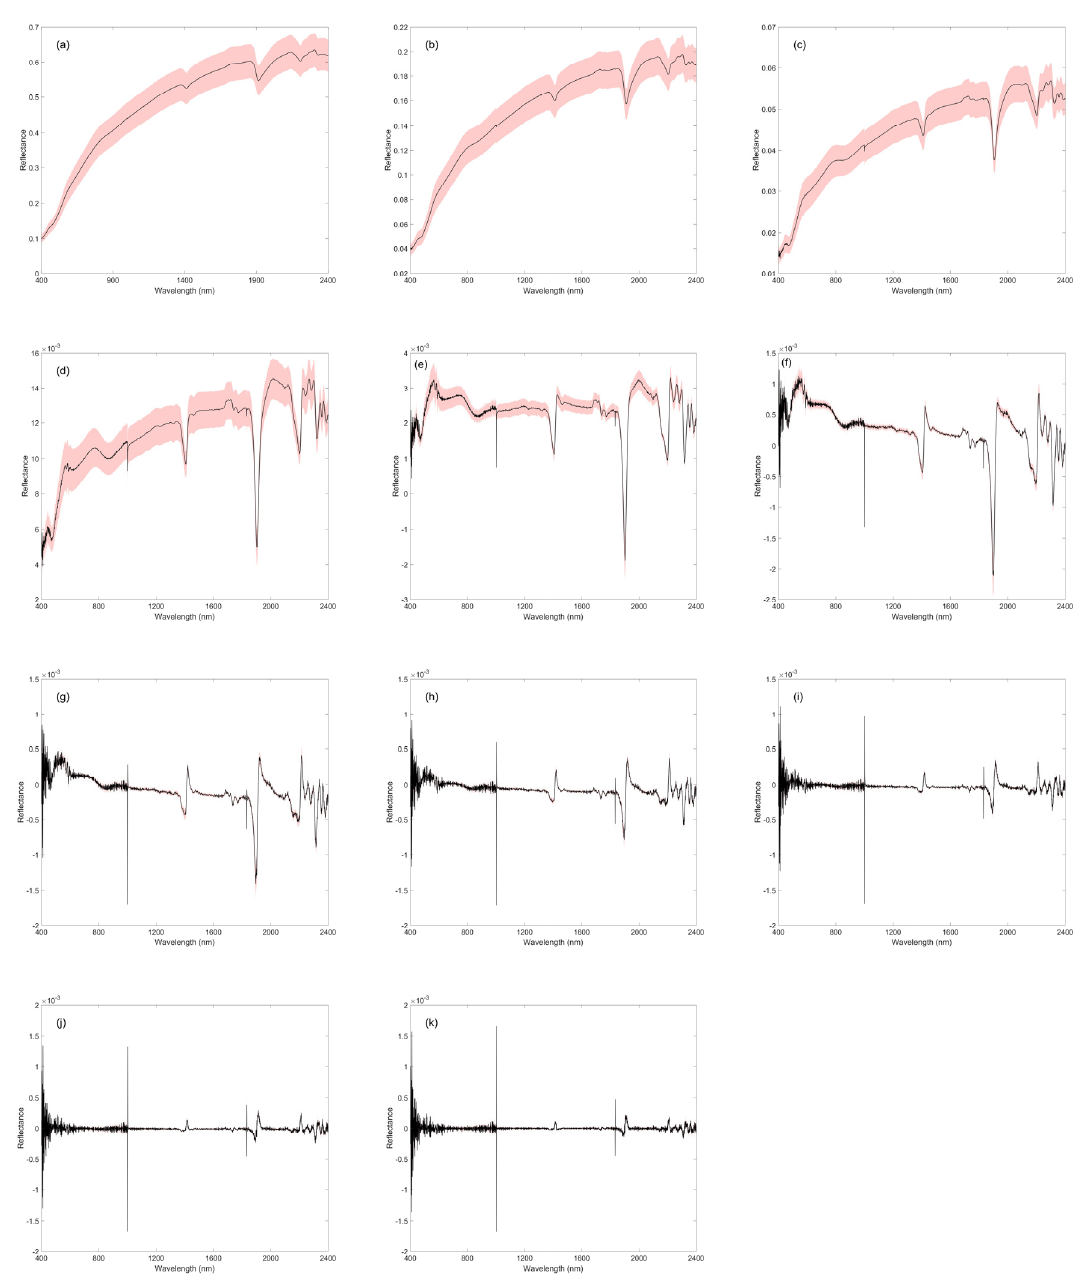
Figure 2. Mean reflectance ( n = 80) processed by fractional-order derivatives in ( a ) 0-order, ( b ) 0.2-order, ( c ) 0.4-order, ( d ) 0.6-order, ( e ) 0.8-order, ( f ) 1-order, ( g ) 1.2-order, ( h ) 1.4-order, ( i ) 1.6-order, ( j ) 1.8-order, ( k ) 2-order. The red areas represent the spectral standard